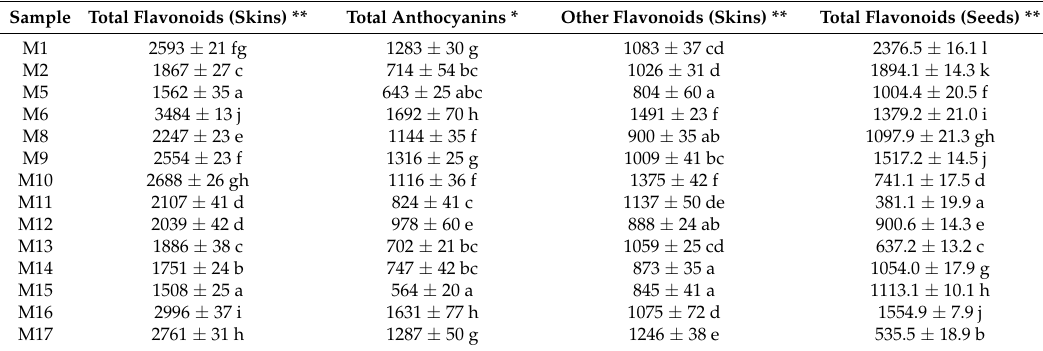
Table 2. Polyphenolic composition of berries (mg/kg).